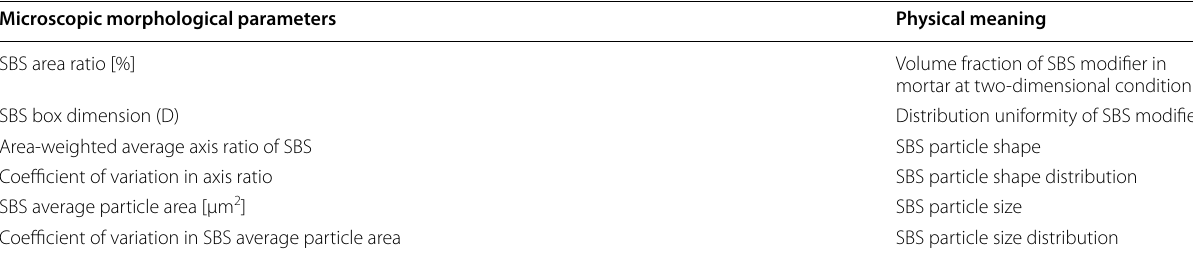
Table 4 Physical meaning of the used microscopic morphological parameters Microscopic morphological